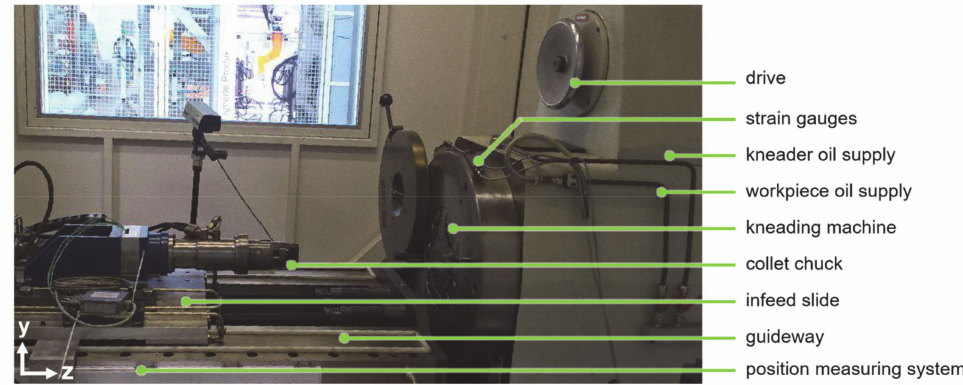
Figure 5. Rotary swaging machine.